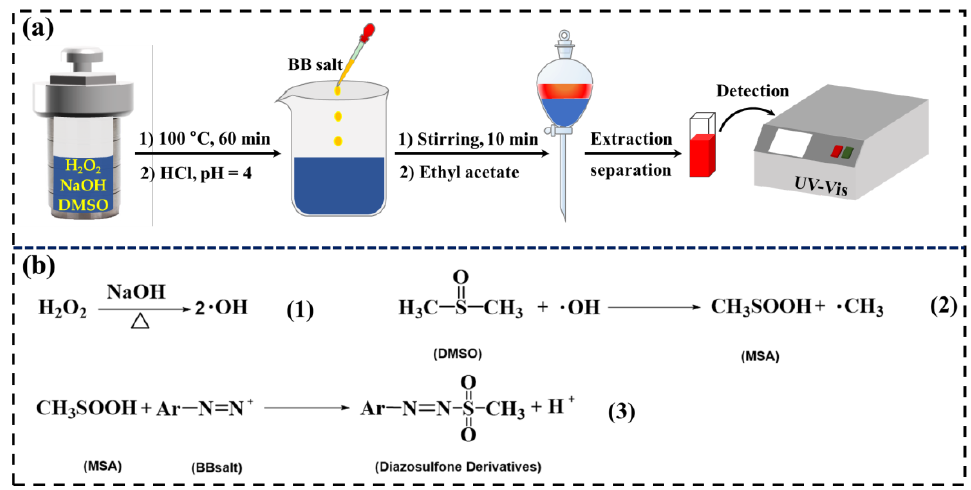
Figure 1. ( a ) The flowchart of the formation and detection of the ·OH. ( b ) Chemical equations in the process of quantitative detection of the ·OH.